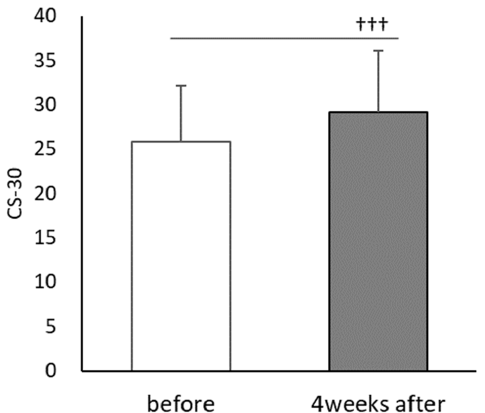
Figure 7. Comparisons of each trial in CS-30 before and after the 4-week PX supplementation period; before: the first session; 4 weeks after: after the 4-week PX supplementation period. ( n = 31); before vs. 4 weeks after: ††† p < 0.001 ( p = 0.000, d = 0.73).